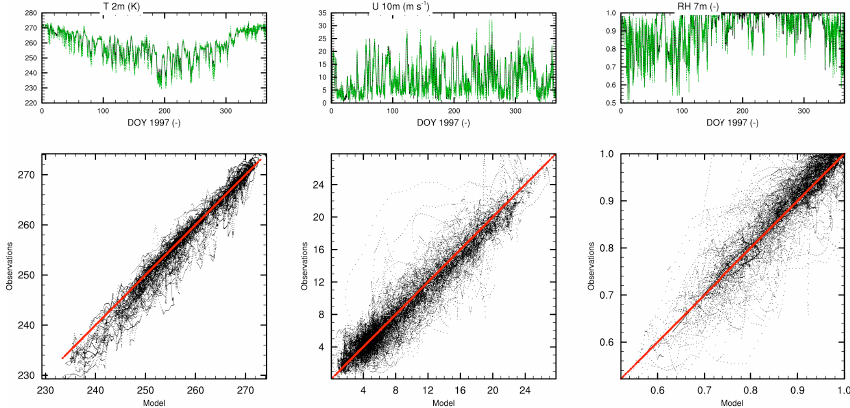
Fig. 6. Time evolution (above) and scatter plots (below) of 12-h interpolated model results vs. hourly observations of near-surface temperature (left), wind (middle) and relative humidity (right) for the year 1997 at Neumayer. Green lines represent the model results and black lines are observations. The 7m RH is shown because it serves as direct input for the snowdrift routine.